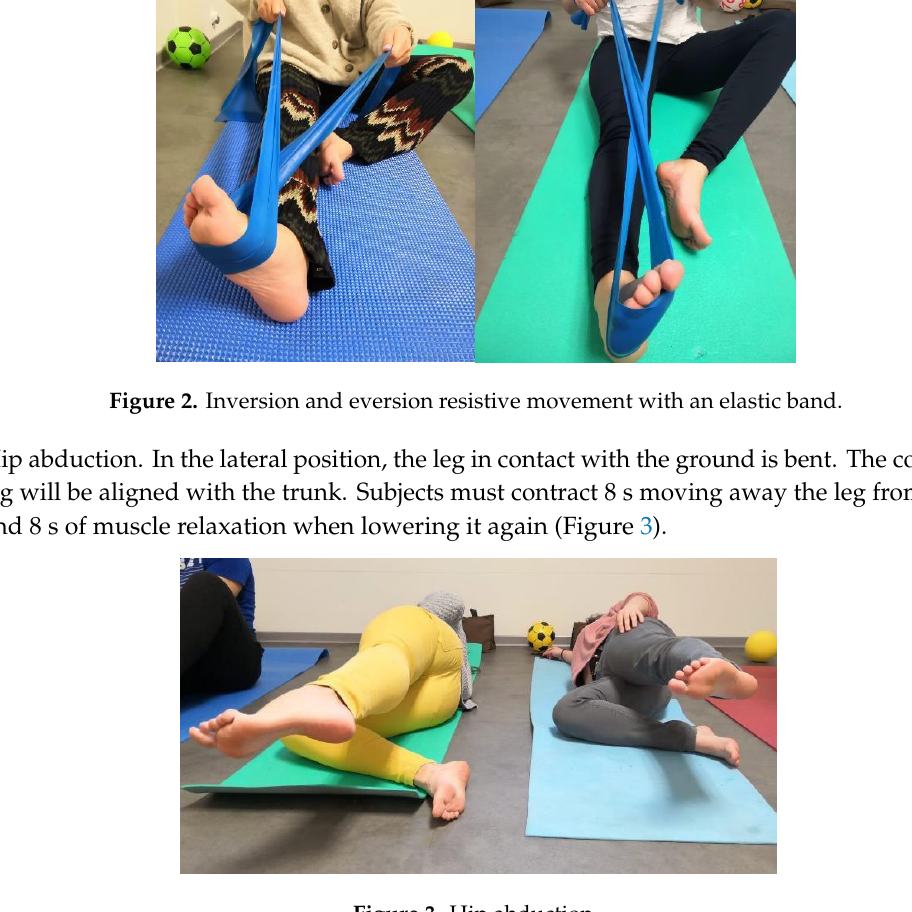
Figure 3. Hip abduction. Figure 3. Hip